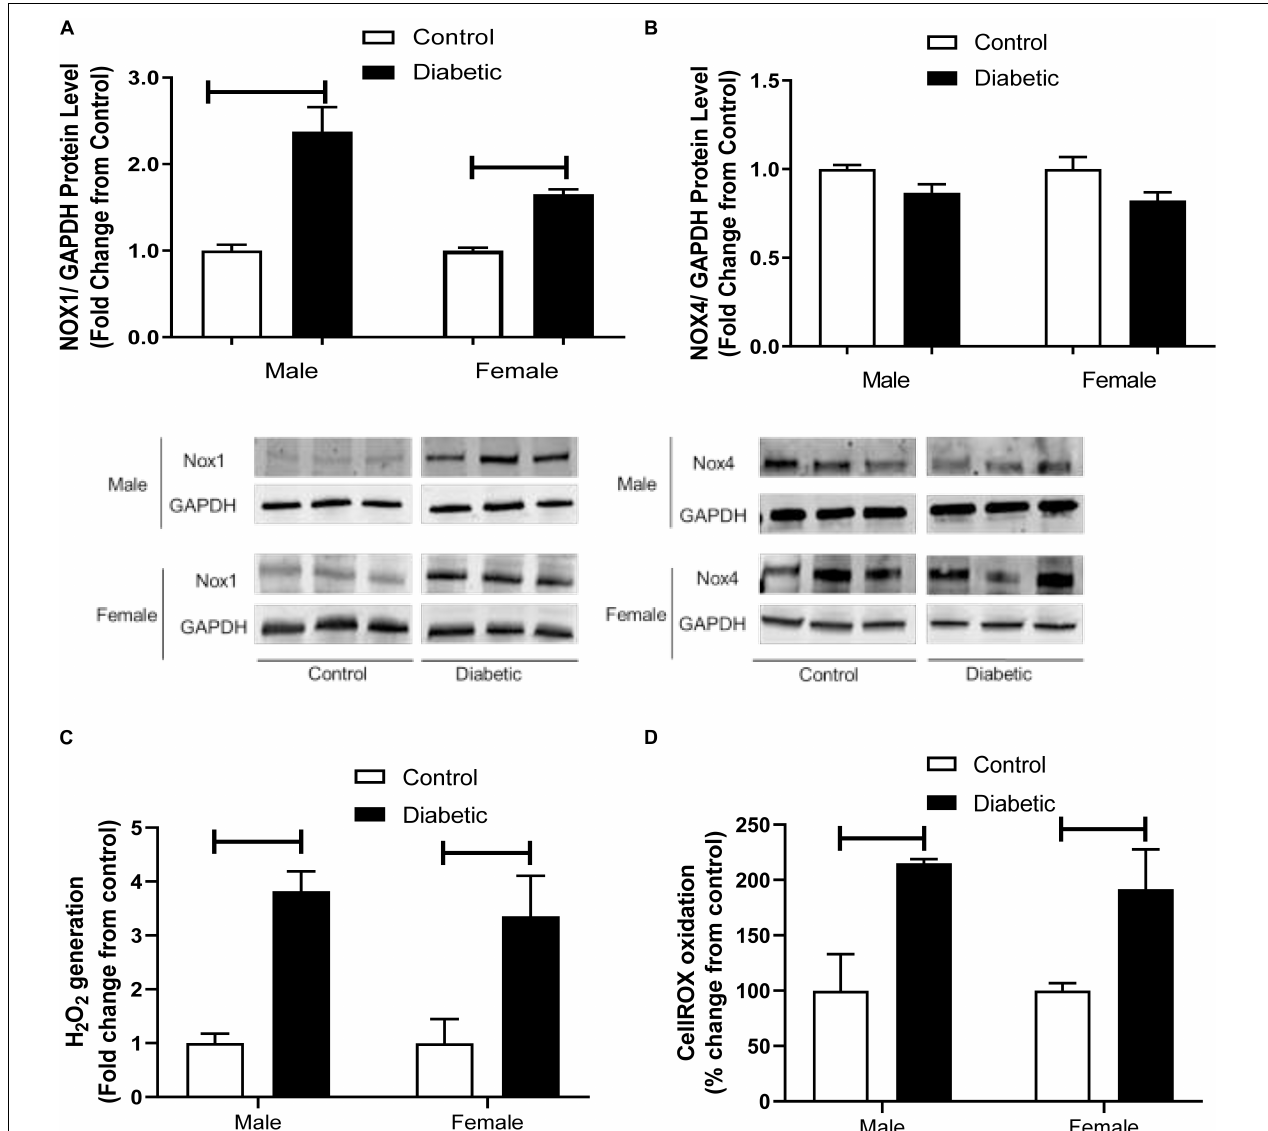
FIGURE 9 | Western blot analysis of NOX1 and NOX4 expression in intact aorta, and oxidant generation in primary aortic endothelial cells isolated from control and UCD-T2DM rats. Protein levels of aortic NADPH oxidases (NOX1) (A) and NOX4 (B) from the samples of male and female control and diabetic rats. NOX1 and NOX4 were quantified by densitometry and normalized to corresponding GAPDH. To show representative bands, images from different parts of the same gel have been juxtaposed, indicated by white dividing lines. Hydrogen peroxide (H 2 0 2 ) (C) and intracellular oxidant (CellROX oxidation) (D) generation in primary aortic endothelial cells isolated from male and female control and diabetic rats. Values are presented as mean ± SEM. Each bar represents the values obtained from n = 4–5 animals per group for NOX expression and n = 3–4 animals per group for oxidant generation studies. Capped lines indicate significant differences between two groups ( p < 0.05), analyzed by unpaired Student’s t